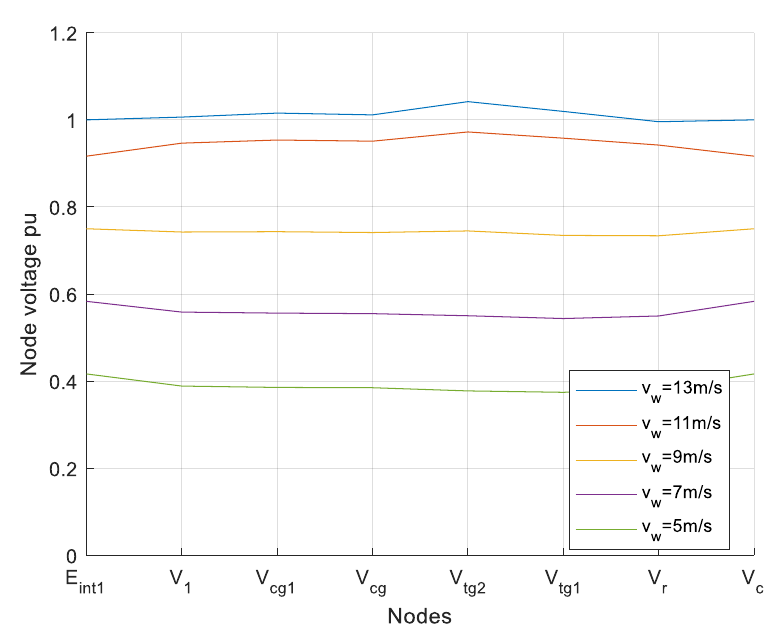
Figure 8. Node voltage for different wind speeds.